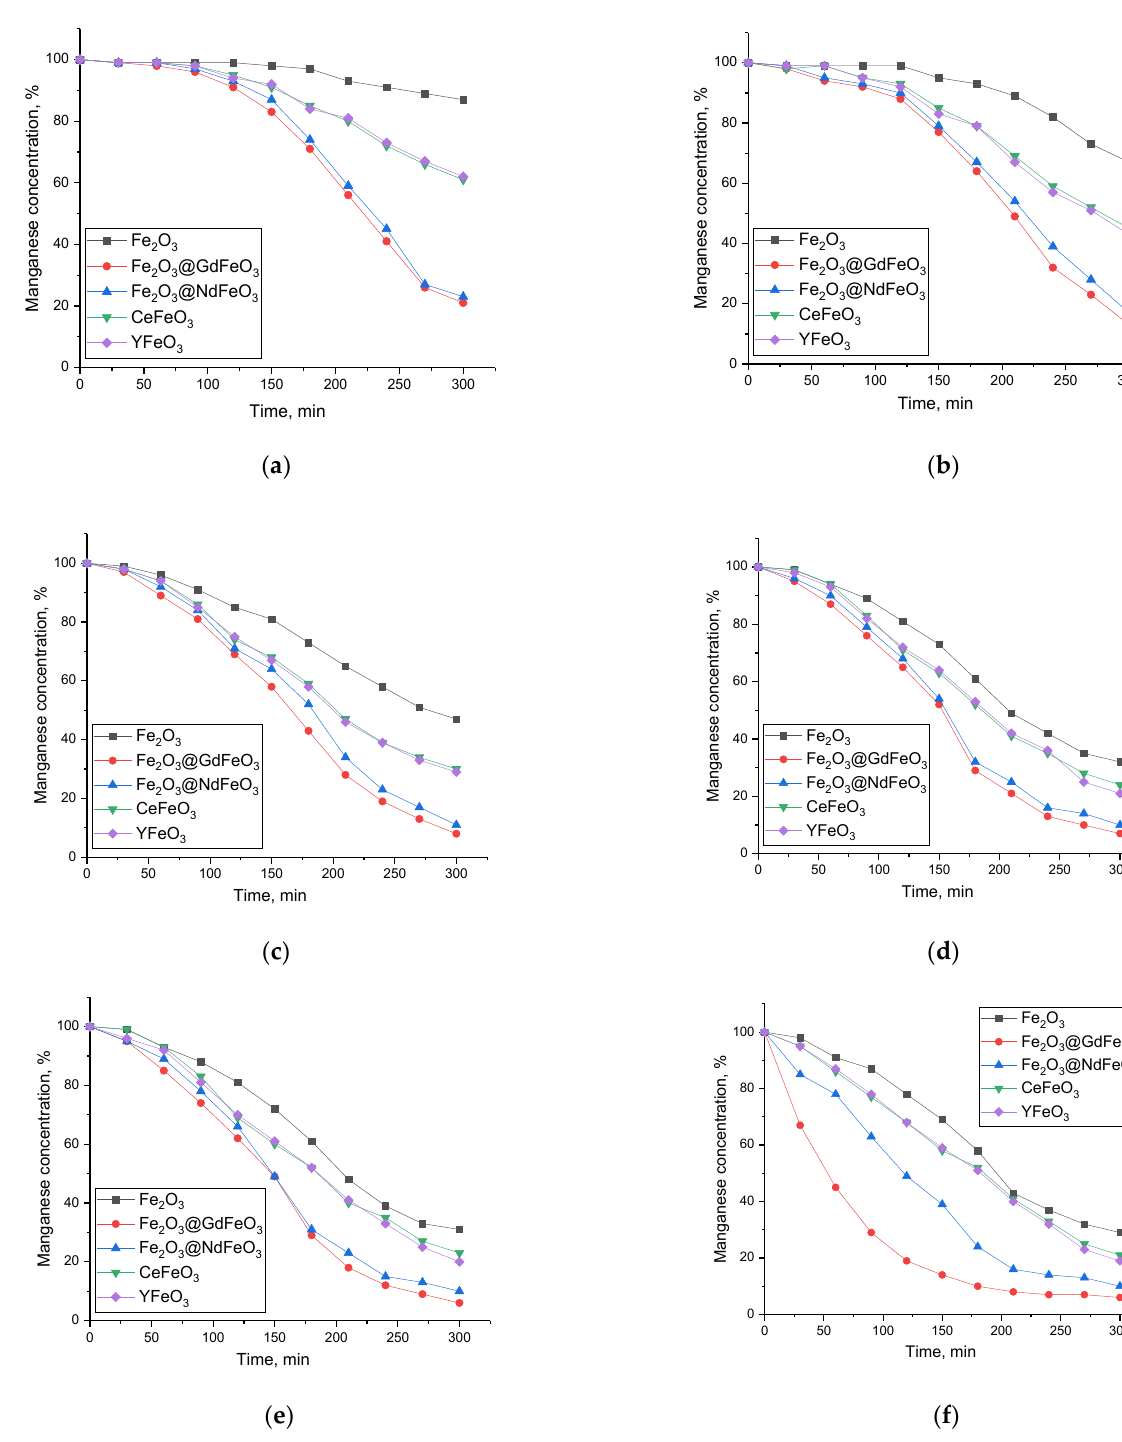
Figure 5. Evaluation results of the manganese concentration change in model solutions depending on time with different contents of the weight fraction of nanoparticles in the model solution: ( a ) 0.01 g; ( b ) 0.05 g; ( c ) 0.10 g; ( d ) 0.25 g; ( e ) 0.50 g; ( f ) 1.00 g.